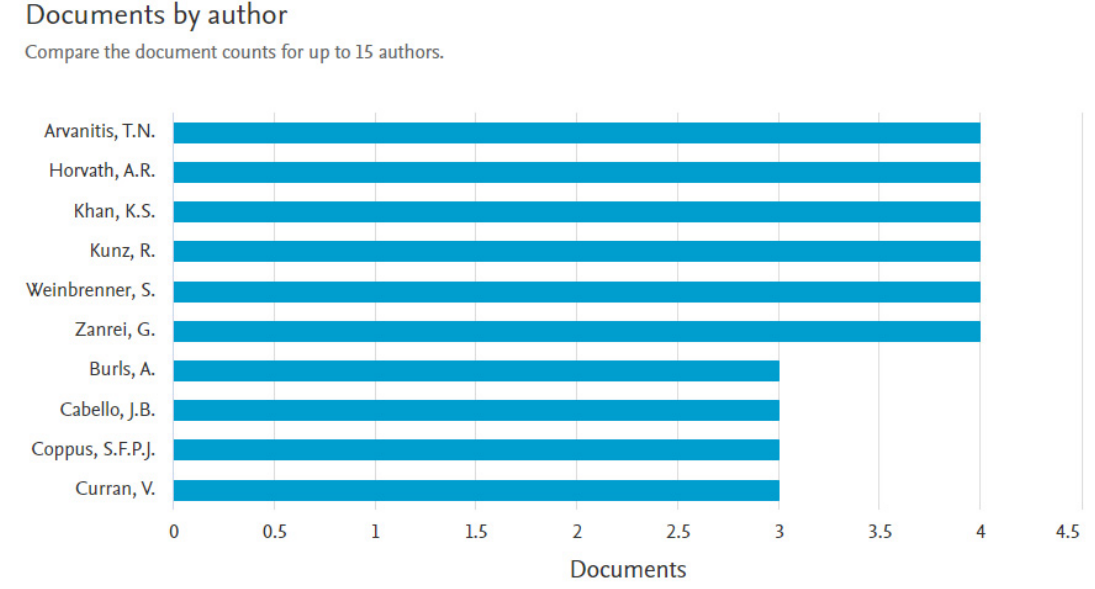
Figure 4. Top publishing authors in Performance evaluation of e-LMED.